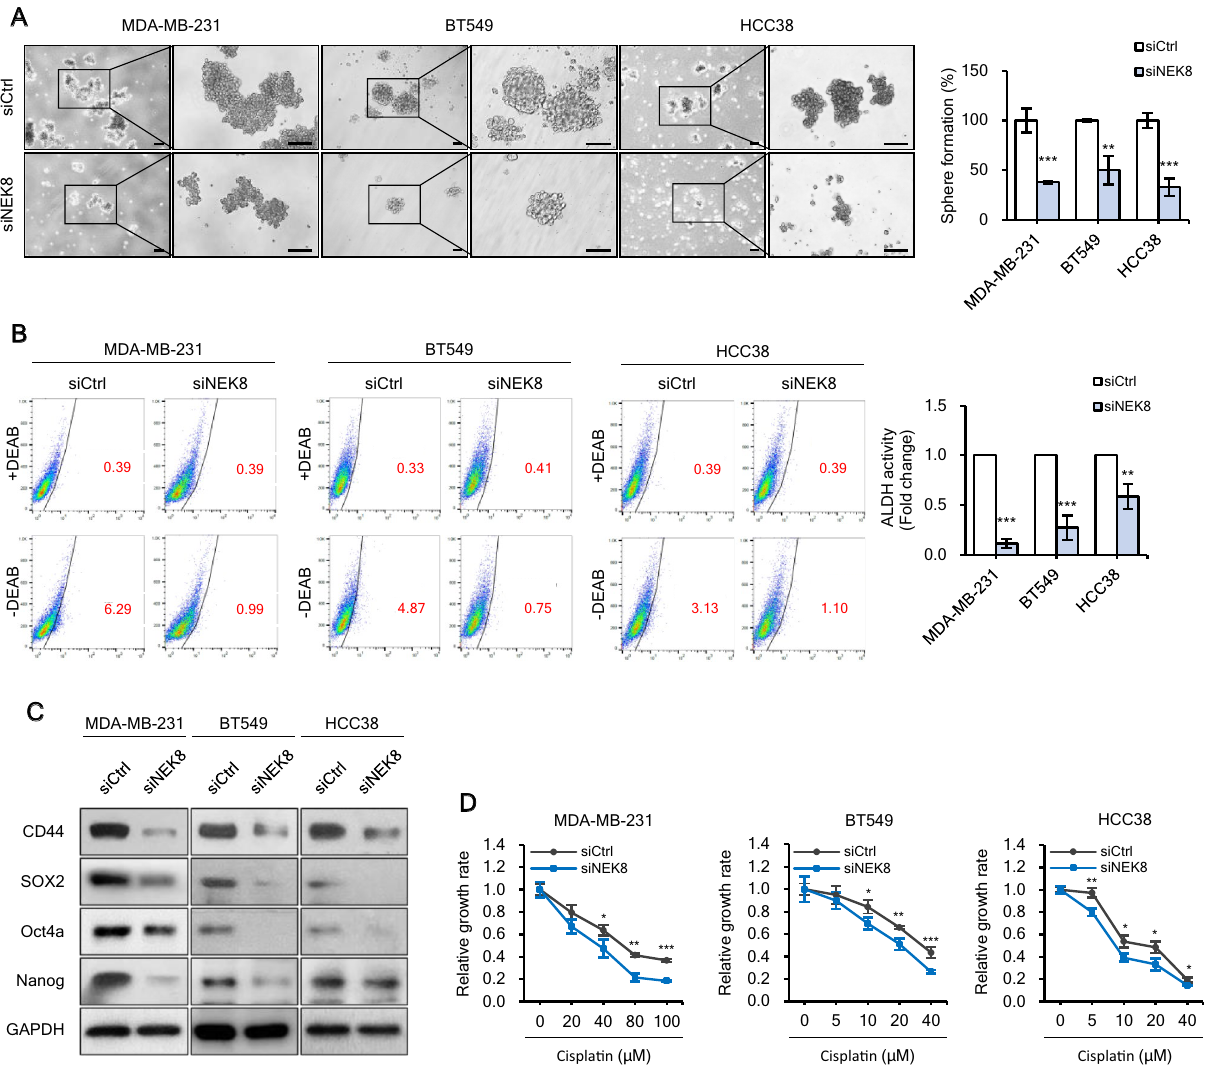
Figure 4. Knockdown of never in mitosis gene A-related kinase-8 (NEK8) inhibits tumour sphere formation, aldehyde dehydrogenase 1 (ALDH1) positive sub-populations, and drug resistance. ( A ) Representative images of spheres induced by culturing MDA-MB-231, BT549, and HCC38 cells treated with siCtrl (control) or NEK8-silencing (siNEK8) in mammosphere medium. NEK8 knockdown inhibited sphere formation in MDA-MB-231, BT549, and HCC38 cells (×40 magnification; scale bar, 100 μm). n = 3; Error bars, standard deviation (SD); *** P < 0.001, ** P < 0.01, * P < 0.05. ( B ) Stemness in MDA-MB-231, BT549, and HCC38 cells was assessed with a ALDEFLUOR assay. Cell populations that disappeared in the presence of the specific ALDH inhibitor diethylaminobenzaldehyde (DEAB) were gated as ALDH high cells. ( C ) Expression of cancer stem-cell- related proteins CD44, SOX2, Oct4a, and Nanog upon the knockdown of NEK8 in breast cancer cells. GAPDH was used as a loading control. The figure is representative of at least two independent experiments (n ≥ 2). The blots were cut prior to incubation with antibodies. ( D ) NEK8 knockdown decreased resistance to cisplatin treatment. The graph is representative of at least two independent experiments (n ≥ 2), where each experiment was performed in triplicate. Error bars indicate SD; *** P < 0.001, ** P < 0.01, ** P <